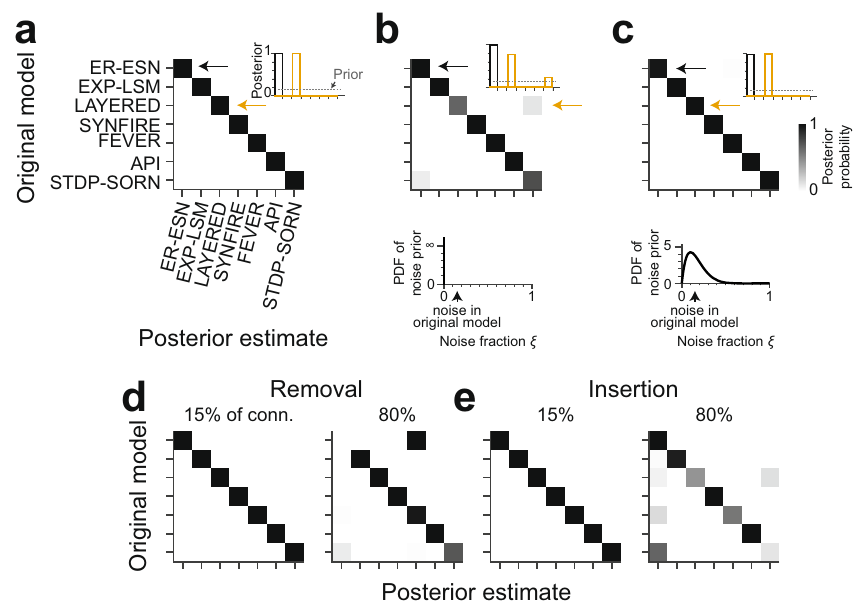
Fig. 4 Identi fi cation of models using Bayesian model selection under ideal and noisy connectome measurements. a Confusion matrix reporting the posteriors over models given example connectomes. Example connectomes were sampled from each model class (rows; Fig. 3b) and then exposed to the ABC-SMC method (Fig. 3d) using only the connectome statistics (Fig. 3a). Note that all model classes are uniquely identi fi ed from the connectomes (inset: average posteriors for ER-ESN and LAYERED connectomes, respectively; n = 3 repetitions). b Posteriors over models given example connectomes to which a random noise of 15% (inset, dashed line) was added before applying the ABC-SMC method. The generative model (Fig. 3b) was ignorant of this noise ( n = 3 repetitions; bottom: noise prior p ξ ð Þ ¼ δ ξ ; 0 ). c Same analysis as in b , this time including a noise prior into the generative model ( n = 3 repetitions). Bottom: The noise prior was modeled as p ξ ð Þ ¼ Beta ð 2 ; 10 Þ . Note that in most connectome measurements, the level of reconstruction errors is quanti fi able, such that the noise can be rather faithfully incorporated into the noise prior (see text). Model identi fi cation is again accurate under these conditions (compare c and a ). d Confusion matrix when simulating split errors in neuron reconstructions by randomly removing 15% (left) or 80% (right) of connections before ABC-SMC inference. e Confusion matrix when simulating merge errors in neuron reconstructions by insertion of additional 15% (left) and 80% (right) of the original number of connections into random locations in the connectome before ABC-SMC inference. d , e Noise prior during ABC-SMC inference was of the same type as the simulated reconstruction errors ( n = 1 repetition; noise prior p ξ ð Þ ¼ Beta ð 2 ; 10 Þ ). Color bar in c applies to all